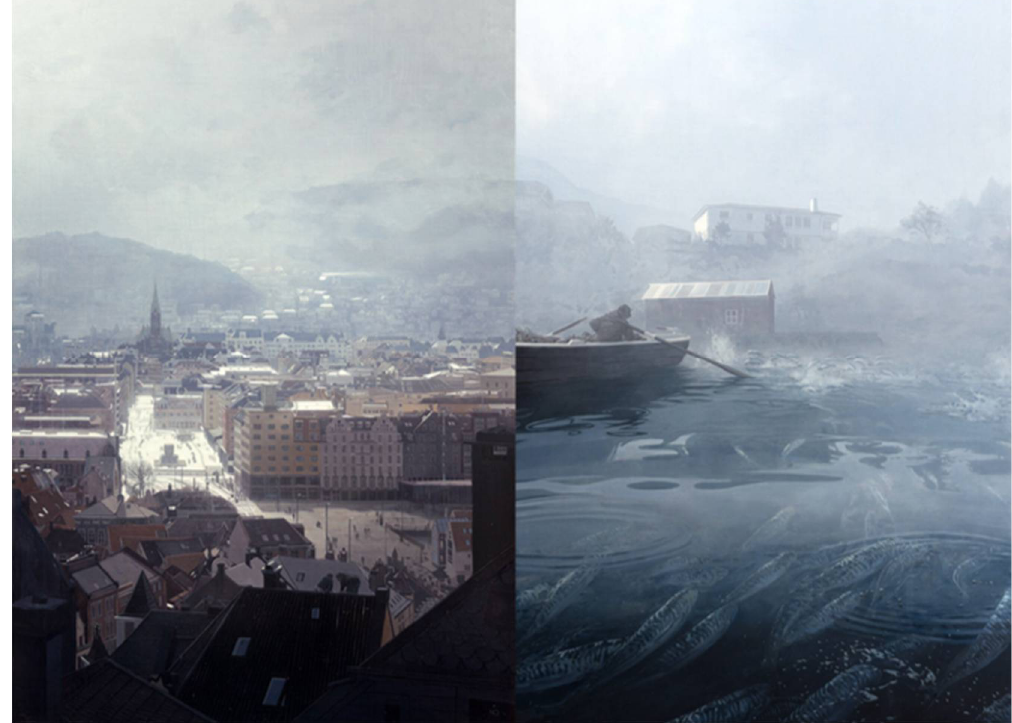
Figure 1. Some paintings from Compositions by Nicholas O’Leary . On the left: Blekeveien, Oil on Canvas (2015); on the right: Siri’s Place, Oil on canvas (2016).